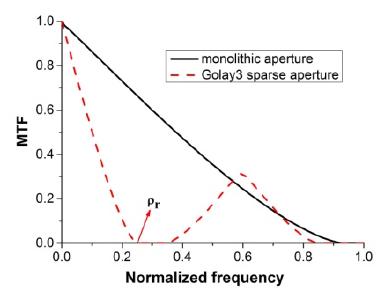
Figure 2. The Modulation Transfer Function (MTF) of the Golay3 aperture.